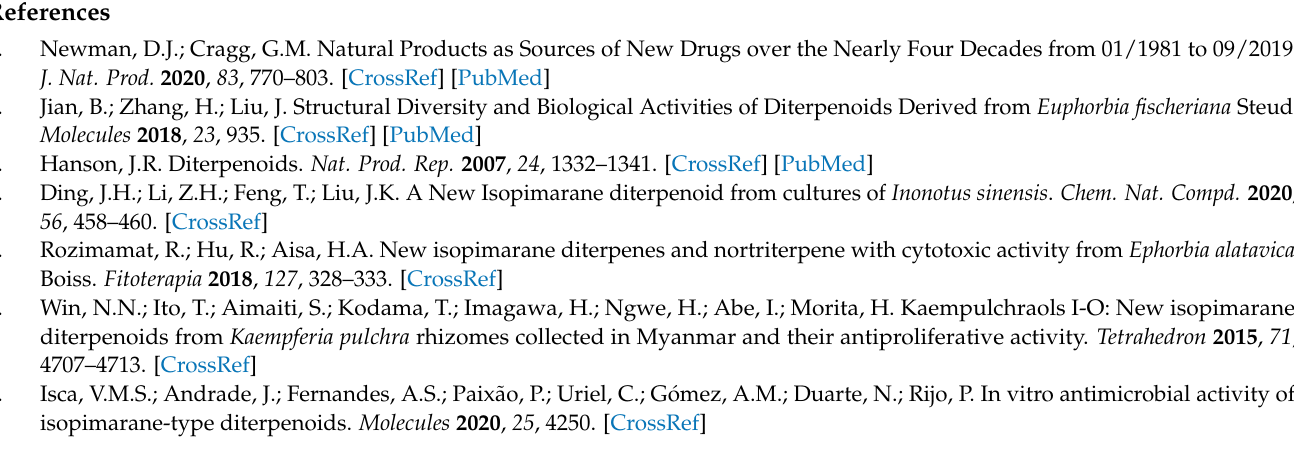
CHCl 3 ; Figure S12: The IR (KBr disc) spectrum of fladin C ( 2 ); Figure S13: The HR-ESI-MS spectrum of fladin C ( 2 ); Figure S14: 1 H NMR spectrum of fladin C ( 2 ) in CDCl 3 (500 MHz); Figure S15: 13 C NMR spectrum of fladin C ( 2 ) in CDCl 3 (125 MHz); Figure S16: DEPT spectra of fladin C ( 2 ) in CDCl 3 ; Figure S17: HSQC spectrum of fladin C ( 2 ) in CDCl 3 ; Figure S18: HMBC spectrum of fladin C ( 2 ) in CDCl 3 ; Figure S19: 1 H- 1 H COSY spectrum of fladin C ( 2 ) in CDCl 3 ; Figure S20: NOESY spectrum of fladin C ( 2 ) in CDCl 3 ; Figure S21: The UV spectrum of fladin D ( 3 ) in CHCl 3 ; Figure S22: The IR (KBr disc) spectrum of fladin D ( 3 ); Figure S23: The HR-ESI-MS spectrum of fladin D ( 3 ); Figure S24: 1 H NMR spectrum of fladin D ( 3 ) in CDCl 3 (400 MHz); Figure S25: 13 C NMR spectrum of fladin D ( 3 ) in CDCl 3 (100 MHz); Figure S26: DEPT spectra of fladin D ( 3 ) in CDCl 3 ; Figure S27: HSQC spectrum of fladin D ( 3 ) in CDCl 3 ; Figure S28: HMBC spectrum of fladin D ( 3 ) in CDCl 3 ; Figure S29: 1 H- 1 H COSY spectrum of fladin D ( 3 ) in CDCl 3 ; Figure S30: NOESY spectrum of fladin D ( 3 ) in CDCl 3 . Refs [34,35] are cited in Supplementary